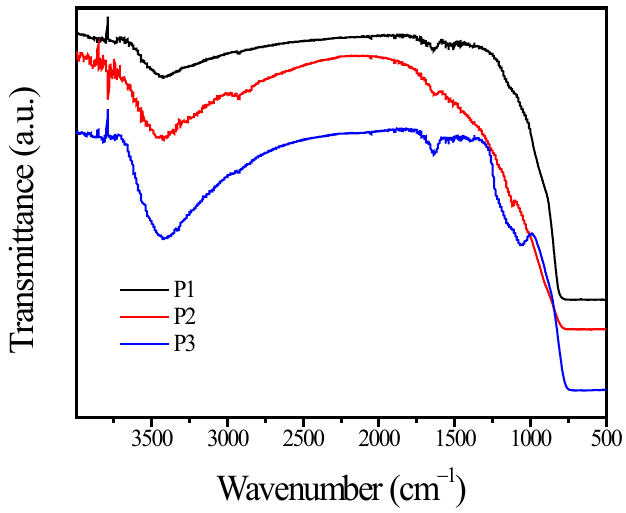
Figure 2. FTIR spectra of the samples.